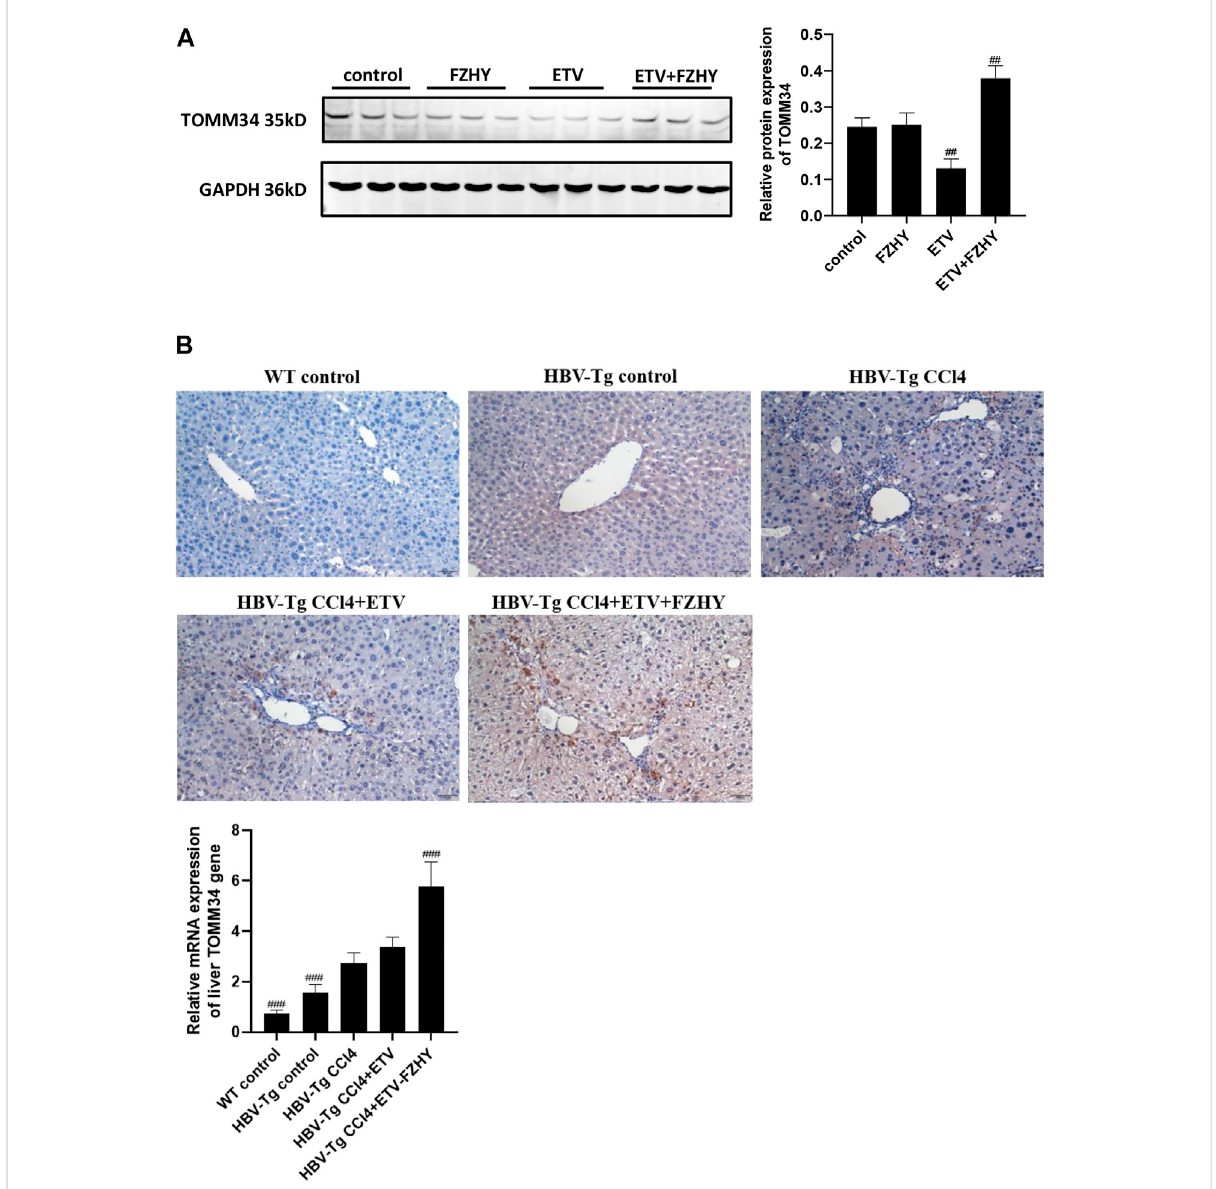
FIGURE 5 Effects of FZHY on the TOMM34 protein production in HepG2.2.15 cells and the TOMM34 gene expression in the liver tissues of CCl4-induced liver fi brosis HBV-Tg mice. (A) The TOMM34 protein production was detected by western blot assay. Each group vs. control group, ## p < 0.01. (B) TheTOMM34gene expression wasdetectedbyimmunohistochemistry stainingand qRT-PCRassay respectively. Eachgroupvs. CCl4-induced liver fi brosis HBV-Tg mice group (HBV-Tg CCl4 group), ### p <